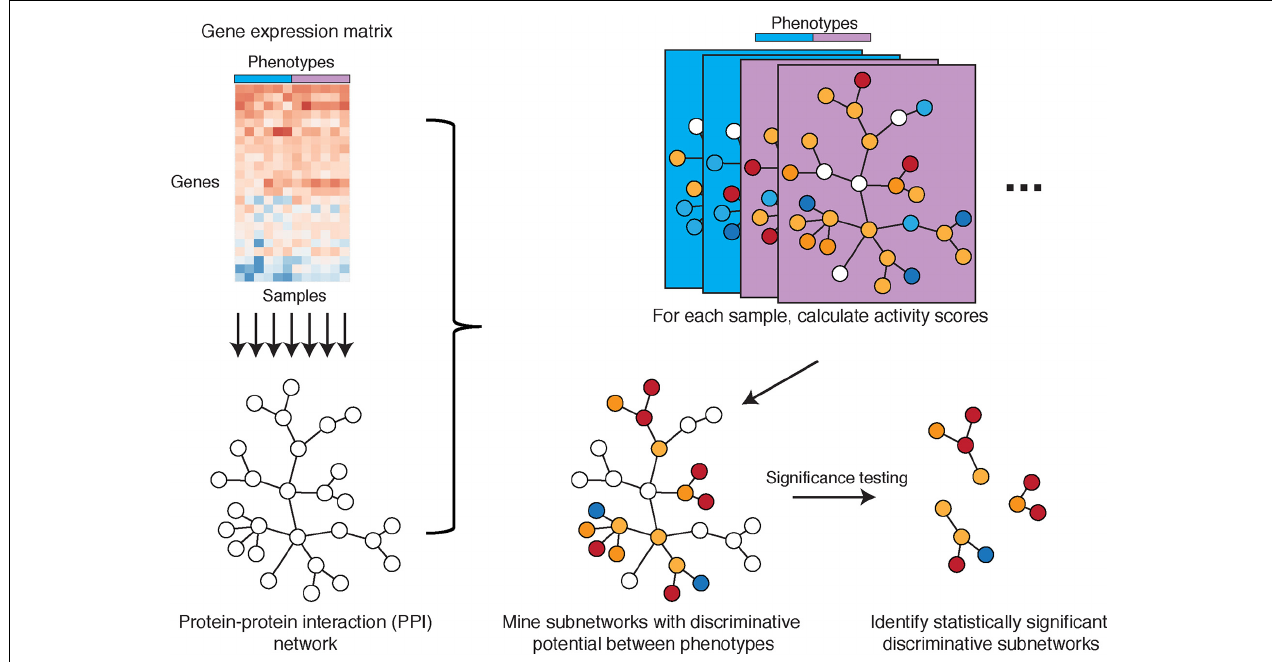
FIGURE 5 | Illustration of the PPI network-based approach by Chuang et al. Gene expression microarray data with phenotype information is overlaid onto a PPI network that is constructed from existing knowledge. Subnetwork activities are calculated per sample based on z-transformed gene expression values, with subnetworks defined by the PPI network. Discriminative potential for each subnetwork is determined by mutual information (or alternatively, t-score or Wilcoxon score) that measures the association between sample activities and phenotypes. Subnetworks with discriminative potential between phenotypes are identified by a greedy search for locally maximal discriminative potential scores. Discriminative subnetworks are further assessed in significance testing to identify statistically significant discriminative subnetworks.